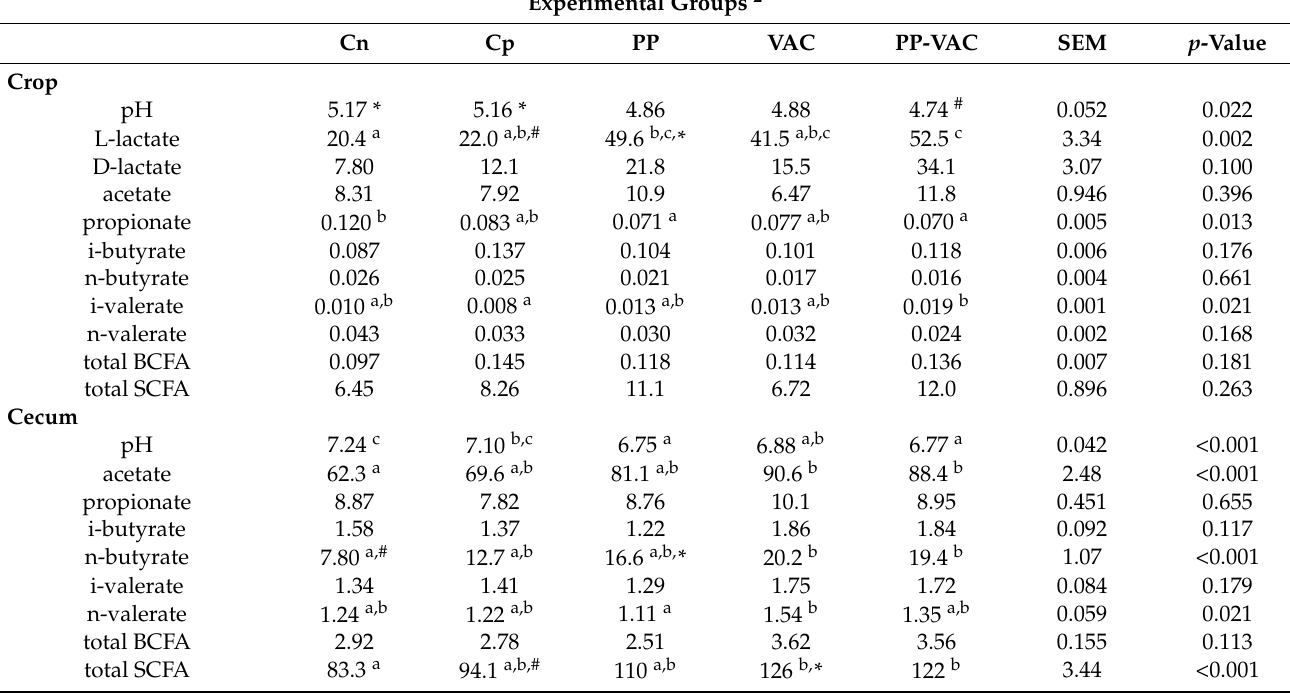
Table 2. Effects of parent stock vaccination and dietary pre-and probiotic combination on pH and lactate, short-chain fatty acid (SCFA), and branched-chain fatty acid (BCFA) concentrations [ µ